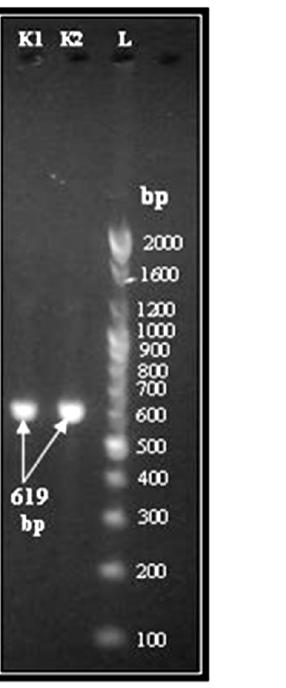
Fig. 2. Agarose gel electrophoresis for bla gene Fig. 1. Conventional PCR for amplification bla OXA-1 bp) of transconjugant E.coli isolates TCK1 and TCK2. Lane in K.pneumoniae isolates with resistant to carbapenem. (L), DNA molecular weight marker (100- bp Ladder). Lane Lane (L), 100- bp DNA Ladder. Lane (1,2) are OXA-1 (TCK2) showing positive result with bla gene (619 bp) positive isolates for bla OXA-1 (TCK1) showing negative result